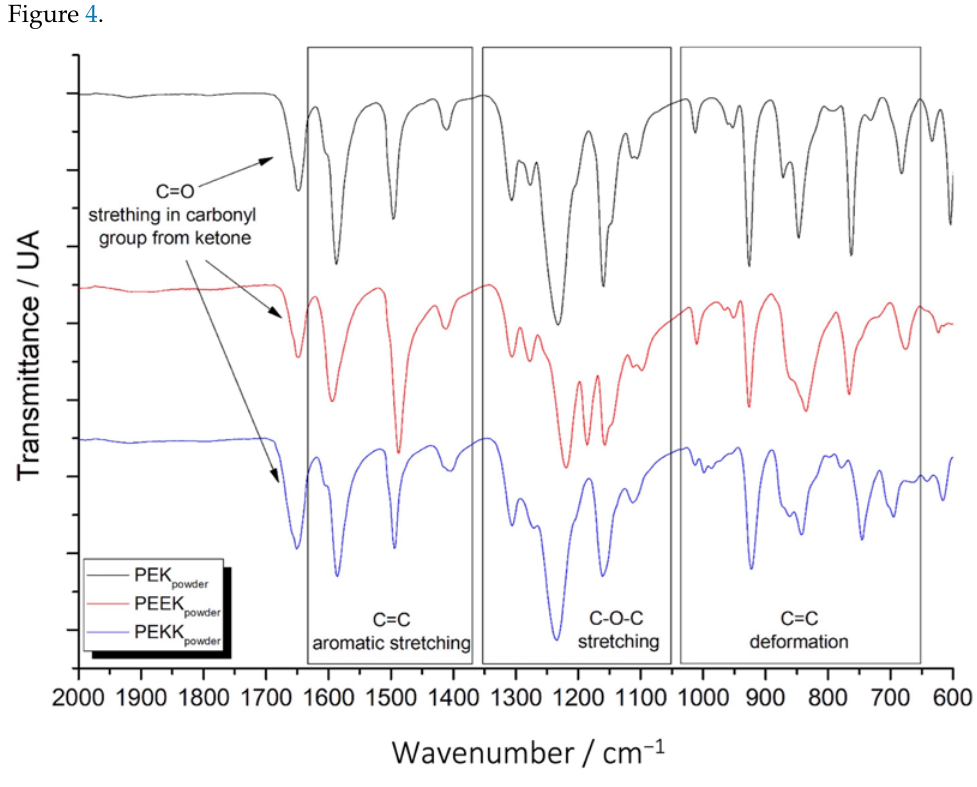
Figure 4. FTIR spectra of binders: PEK, PEEK and